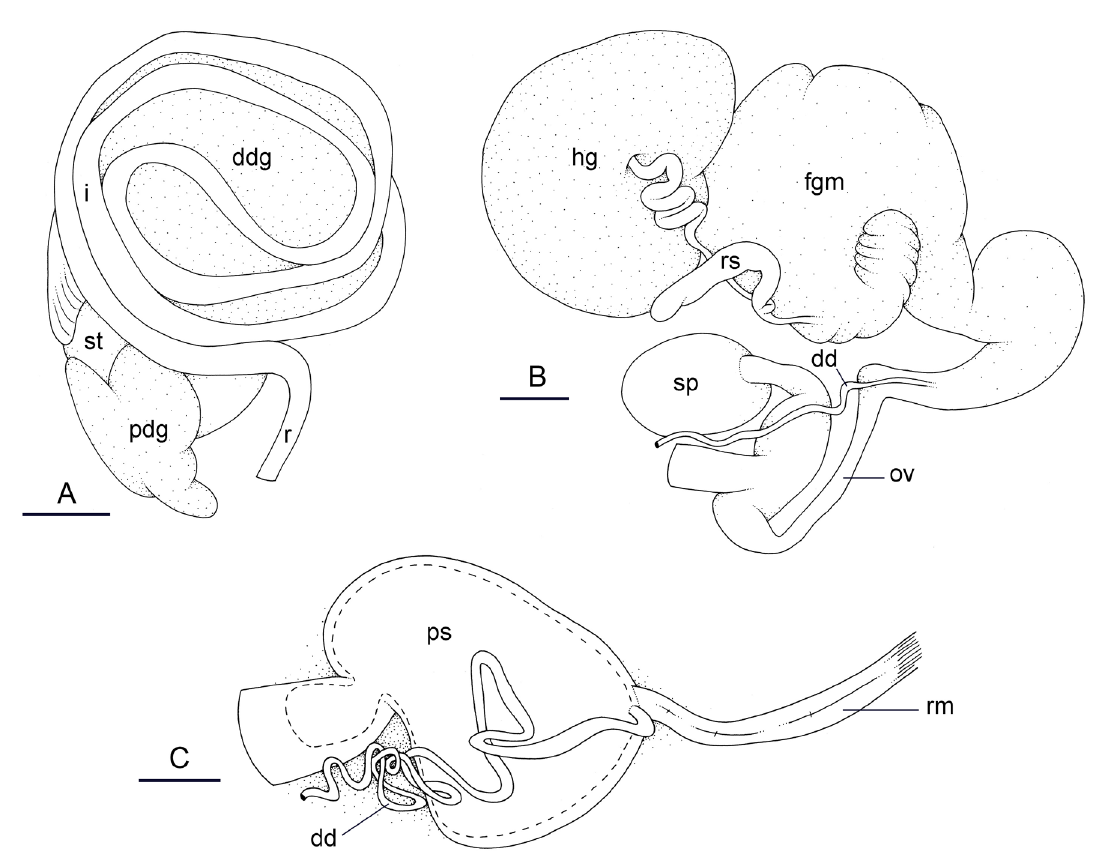
Fig. 42. Paromoionchis penangensis gen. et sp. nov., holotype, Malaysia, Penang [6037] (USMMC 00059). A . Digestive system. B . Posterior hermaphroditic (female) reproductive system. C . Male copulatory organs. Abbreviations: dd = deferent duct; ddg = dorsal lobe of digestive gland; fgm = female gland mass; hd = hermaphroditic duct; hg = hermaphroditic gland; i = intestine; ov = oviduct; pdg = posterior lobe of digestive gland; ps = penial sheath (penis inside indicated by dotted line); r = rectum; rm = retractor muscle; rs = receptaculum seminis; sp = spermatheca; st = stomach. Scales: A = 2 mm; B–C = 1